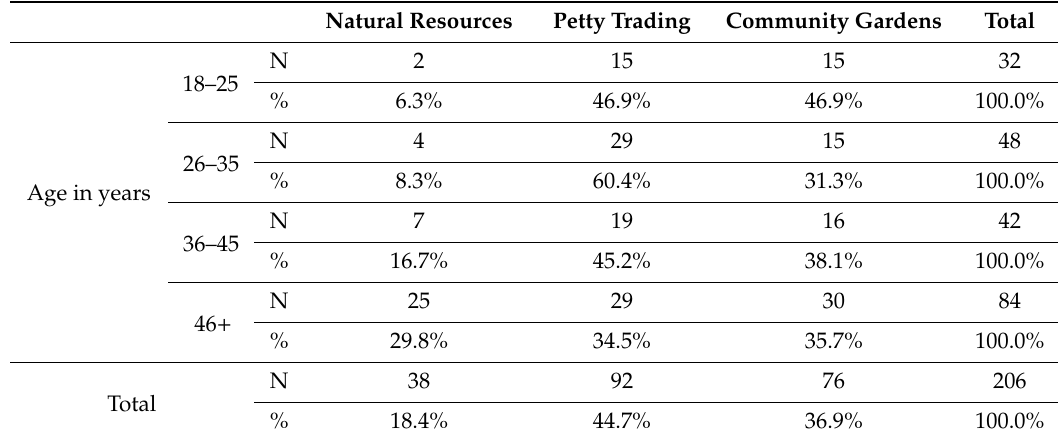
Table 2. Demographic profile of Beitbridge smallholder livestock farmers. Natural